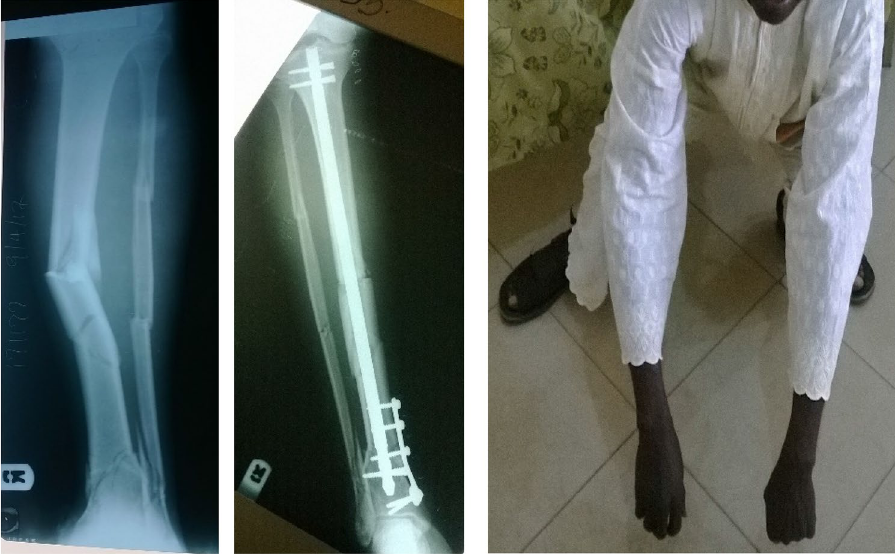
Figure 3. Pre- and post-operative radiographs and “squat and smile” photograph (6-month follow-up) of a 50-year old man who had AO/OTA 32C3 (not shown) and 42C3 fractures. The SIGN nail was combined with a side plate to treat the most distal tibia fracture.